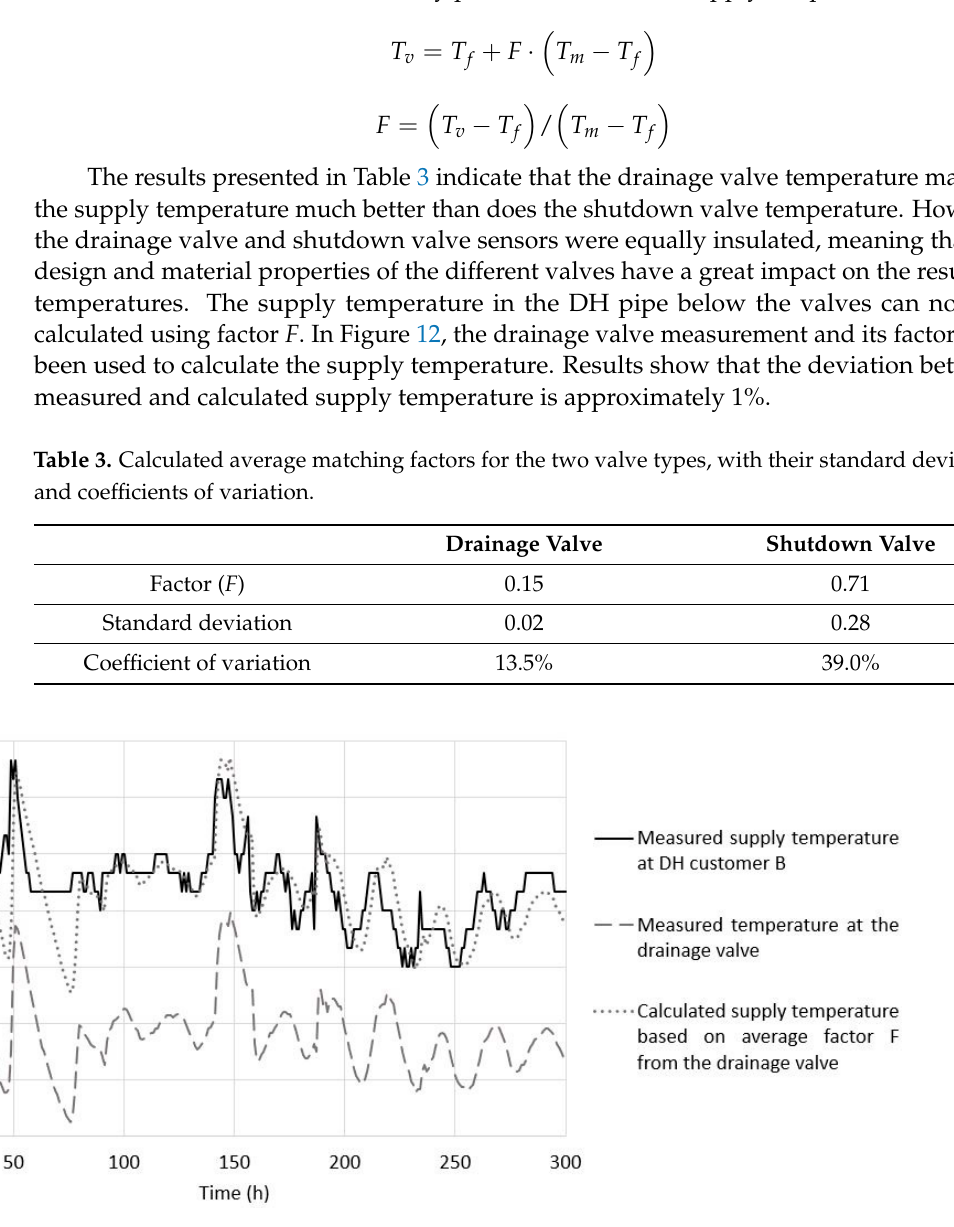
Figure 12. Calculated supply temperature in the DH pipe based on factor F for the drainage